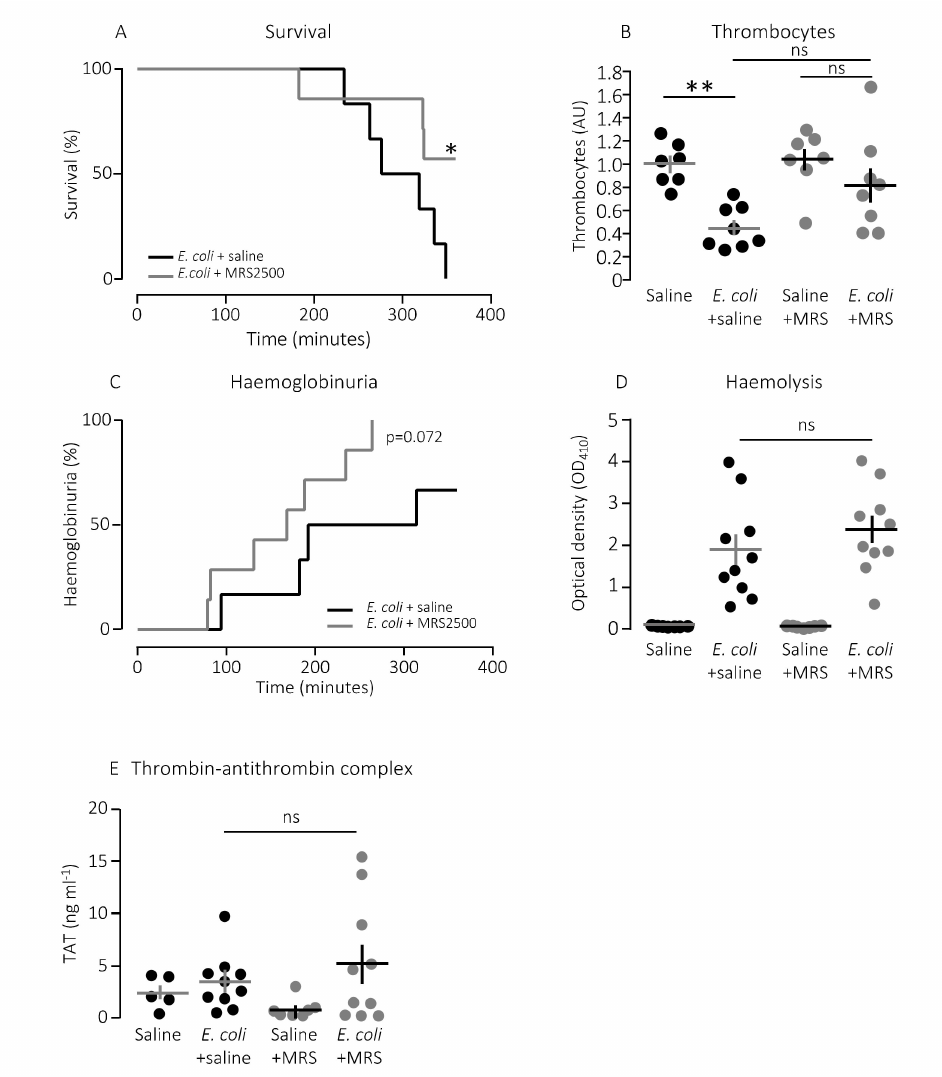
Figure 2. P2Y 1 receptor antagonist MRS2500 (MRS) increase survival of mice exposed to sepsis with E. coli